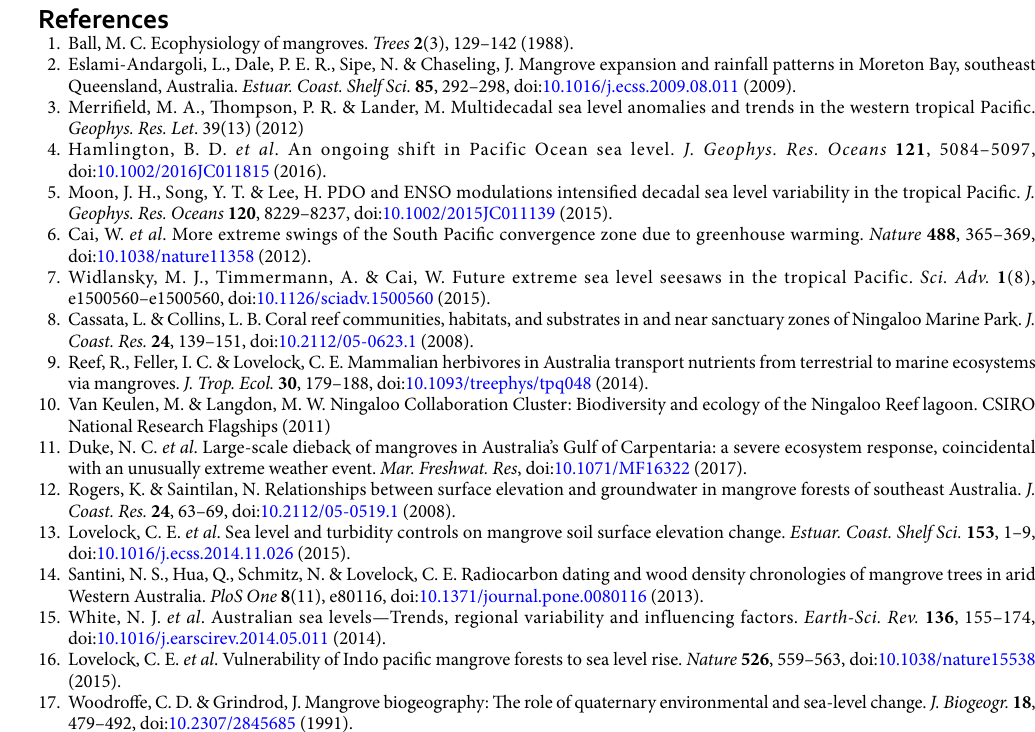
ESRI ArcGIS was used to calculate the Normalized Difference Vegetation Index (NVDI) (Equation 1) (30 m pixel) for the study region. True and false colour scene composites were used to visually determine NDVI minimum and maximum thresholds for mangroves each year. An accuracy assessment from high-resolution aerial imagery for available years (1999, 2003, 2010) was undertaken and Cohen’s kappa was used to measure agreement, k = 0.800 (95%CI, 0.784 to 0.816), p < 0.0005. Euclidean distance to each pixel centroid was also measured from the creek entrance at the northern site. The relationship between mean annual NDVI, sea level and rainfall was assessed using linear regression. We used an F-test to assess whether a linear model including annual rainfall as well as mean annual sea level explained a significantly greater proportion of the variation in annual NDVI compared to a model with only sea level as the explanatory variable. The analysis of the relationship between distance from the mouth of the creek and the coefficient of variation of NDVI and mean NDVI for individual pixels were assessed using linear regression.